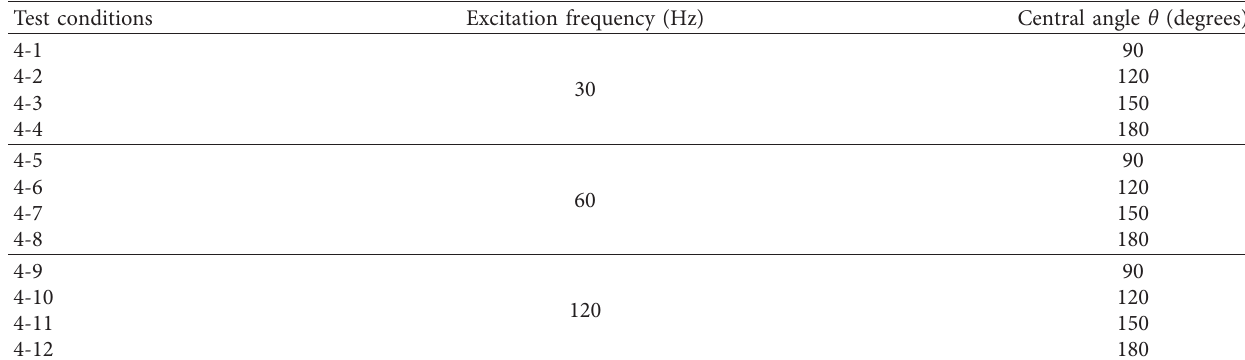
Figure 10: Fitting curve of L and η Table 10: Test arrangement for the parameter θ .